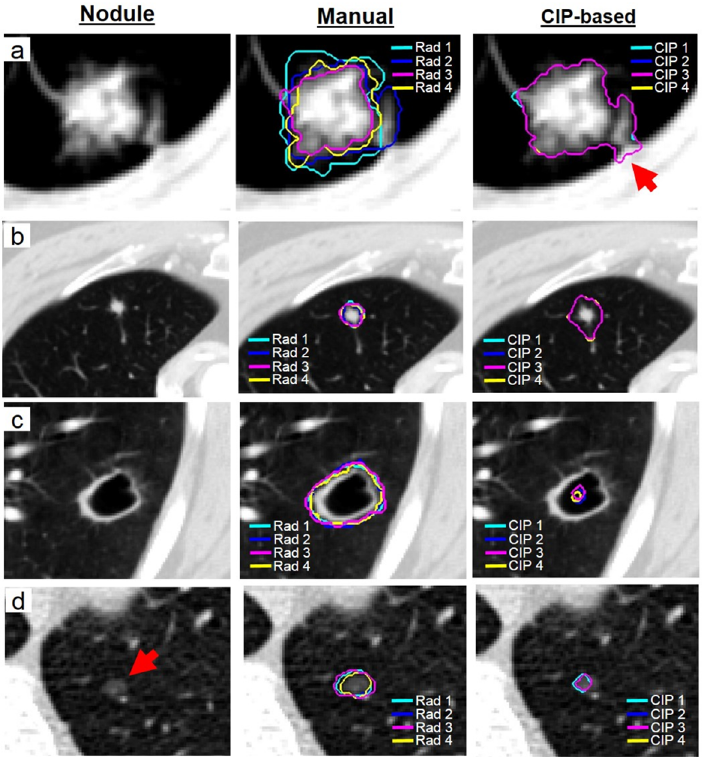
Fig 4. Examples of nodules that were segmented by radiologists manually and CIP segmentations. a) The robustnessof the CIP segmentation was excellent,whilesubstantialinterobservervariabilitywas observedin manual segmentation. CIP segmentation was also in excellentagreement with manualcontours. However, CIP segmentation was observedto includepart of the chest wall (indicatedby an arrow) b) Despite being perfectly robust CIP segmentation, it includedthe regionof the normal lung in proximity of the small nodule.c) Cavitationin the center of the nodule.Poor CIP segmentation performance was found. d) Non-solid (groundglass opacity) nodulewith poorlydefinedboundaryand subtle appearanceis indicatedby the red arrow. Poor CIP segmentation performance was